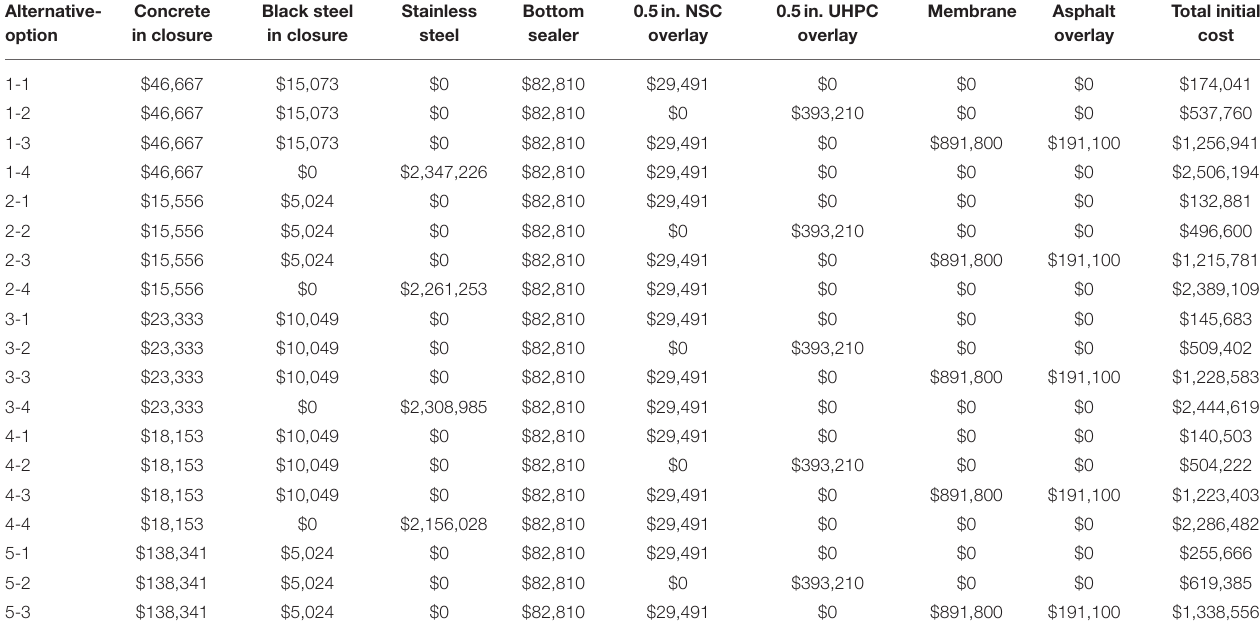
TABLE A1 | Breakdown of material initial cost analysis for